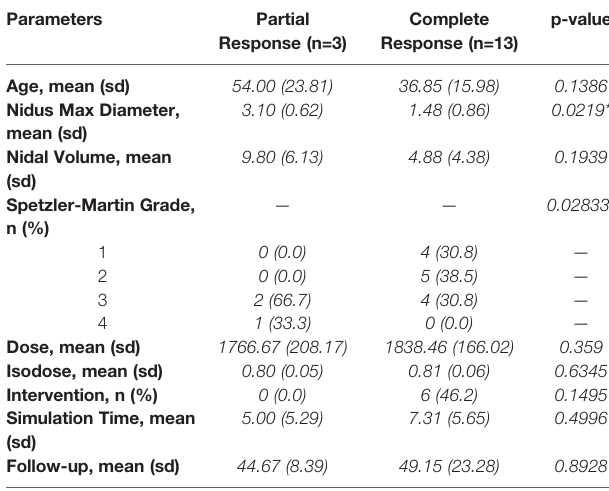
TABLE 3 | Kruskall-Wallis Rank Test of AVM Response